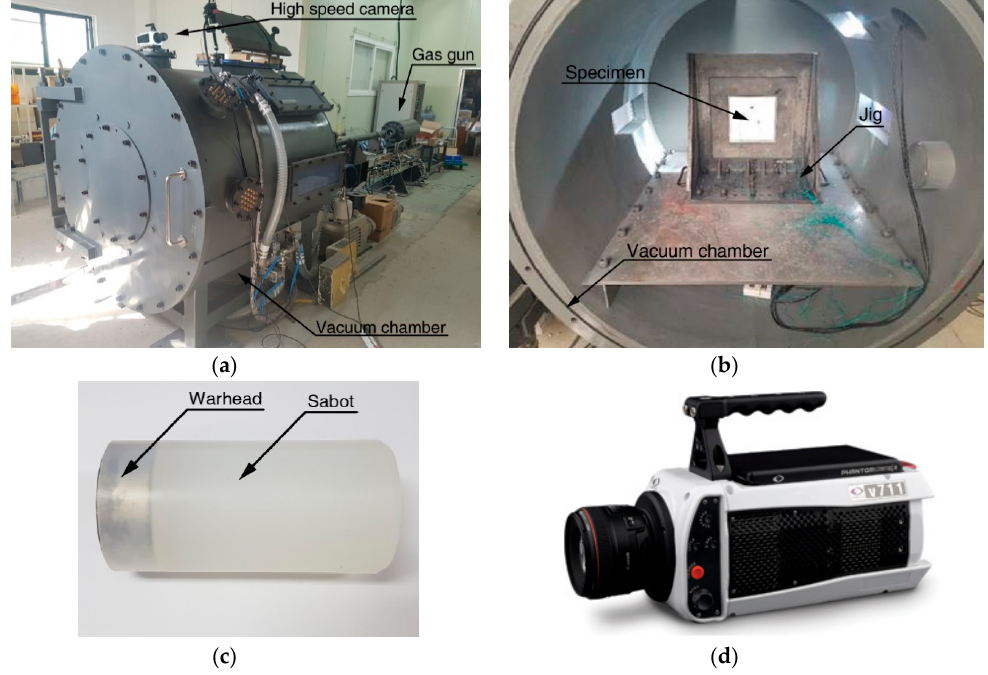
Figure 1. ( a ) Gas-gun system, ( b ) vacuum chamber, ( c ) projectile set, and ( d ) high-speed camera (Phantom V711).